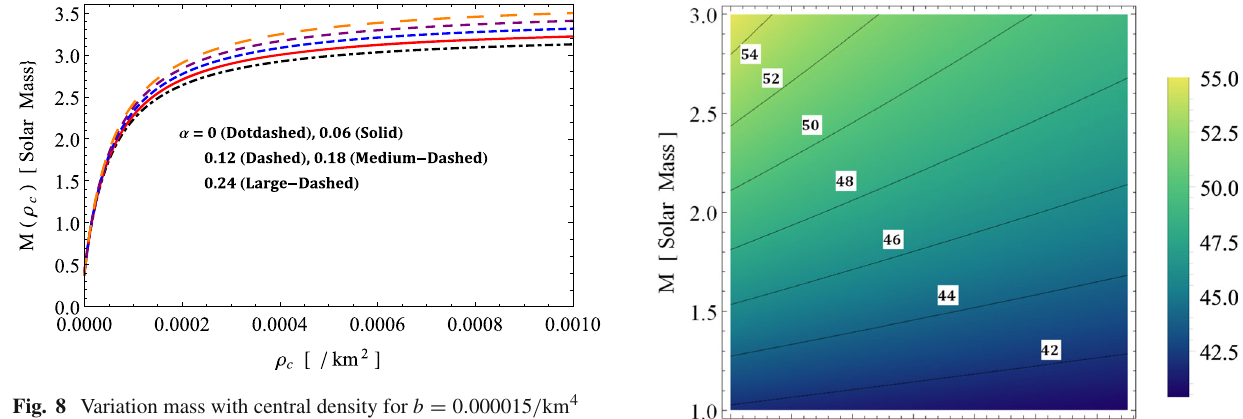
Fig. 8 Variation mass with central density for b = 0 . 000015 / km 4